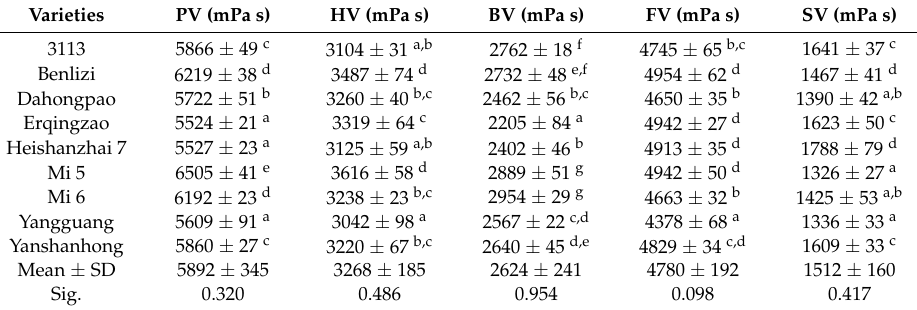
Table 5. Pasting parameters of starch.